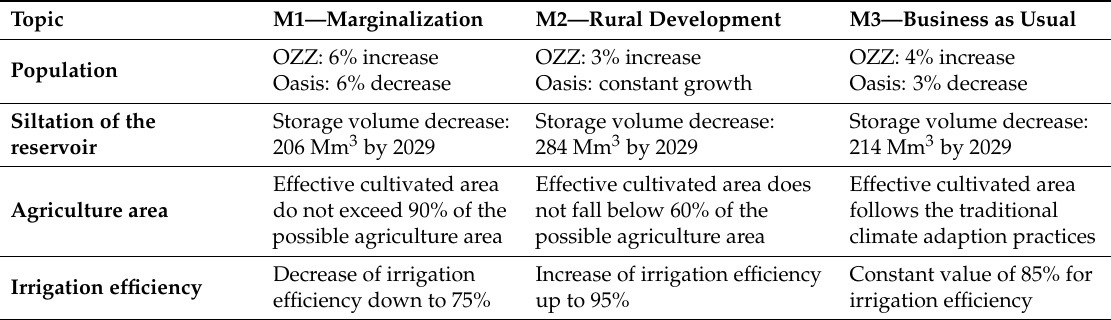
Table 2. Characteristics of the IMPETUS scenarios M1, M2, and M3 (2008-2029) [24,31] (OZZ: city of